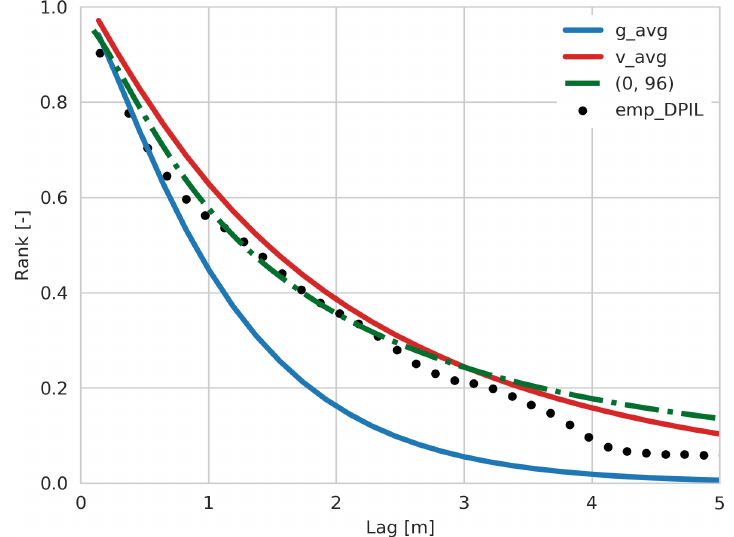
Figure 12. Comparison between the Gaussian copula parameter estimation with 4% right side detection limits (dash-dotted green linewith label (0, 96)), without detection limit (solid blue line with label g_avg), v-copula parameter estimation without censored threshold (sold red line with label v_avg) and